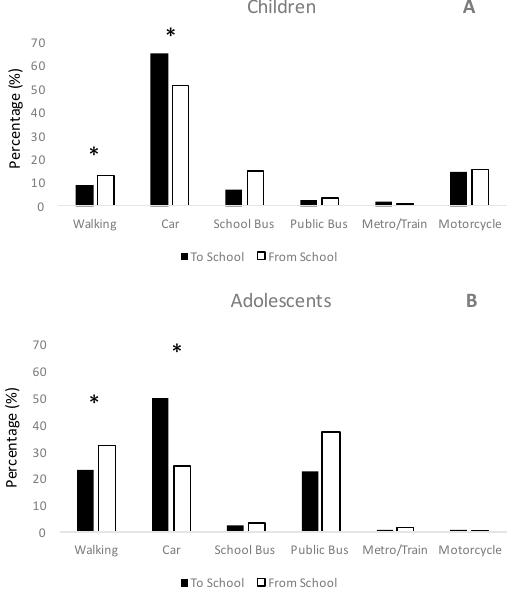
Figure 1. Comparison of the modes of commuting to and from school, in children ( A ) and adolescents ( B ). * p < 0.05 value between “To school” and “From school” in children and adolescents by car and walking.